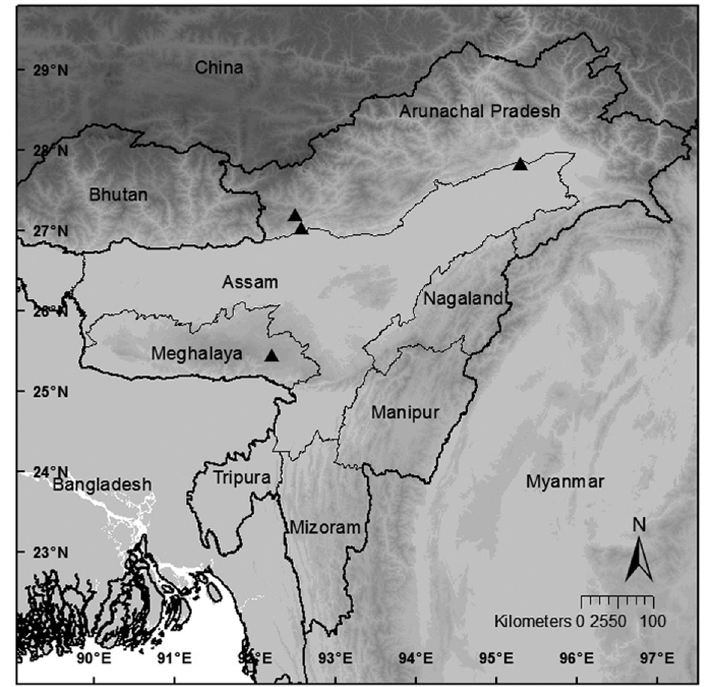
Fig. 40. Map showing the location of B. nepalensis (A.DC.) Warb.